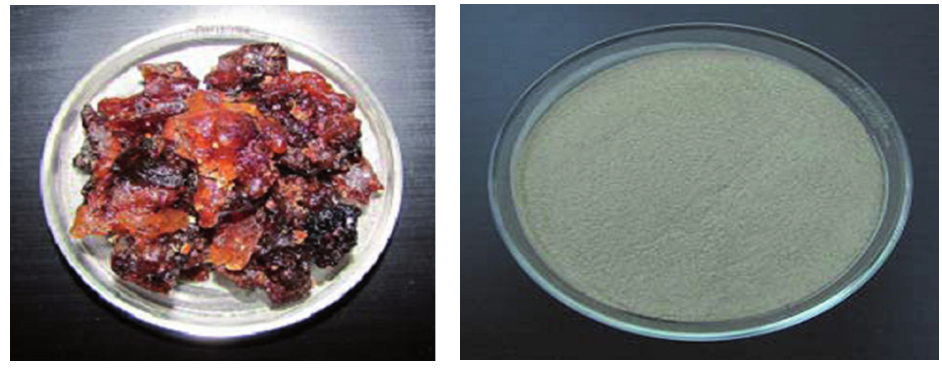
F 1: Crude and puri�ed FP